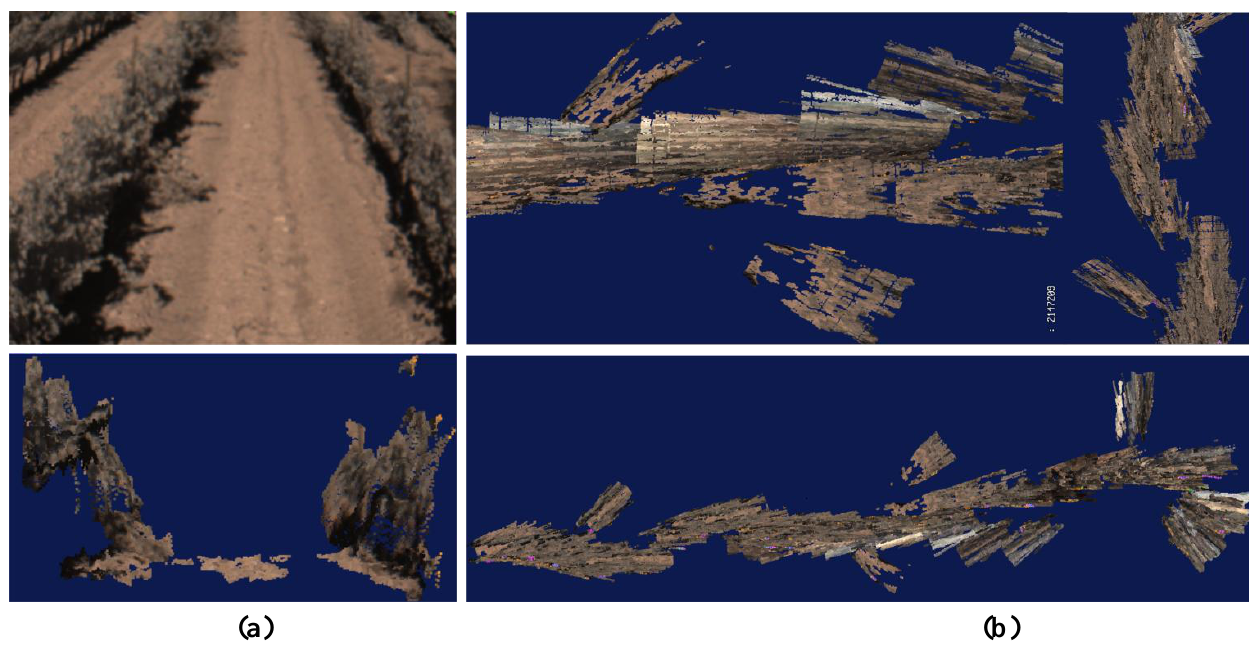
Figure 11. 3D terrain mapping: (a) Sample image (top) with its 3D view (bottom). (b) Heading errors in top